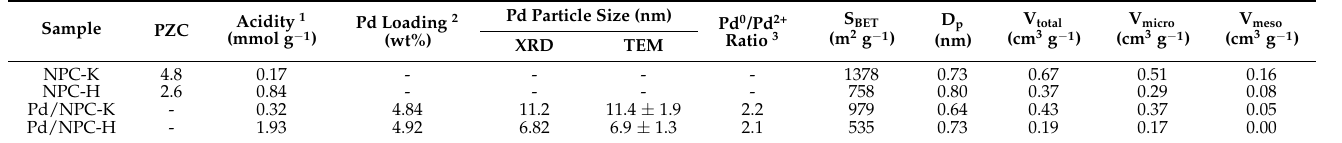
Table 4. Characteristics of the NPC-K and NPC-H materials and the Pd/NPC-K and Pd/NPC-H catalysts. Sample